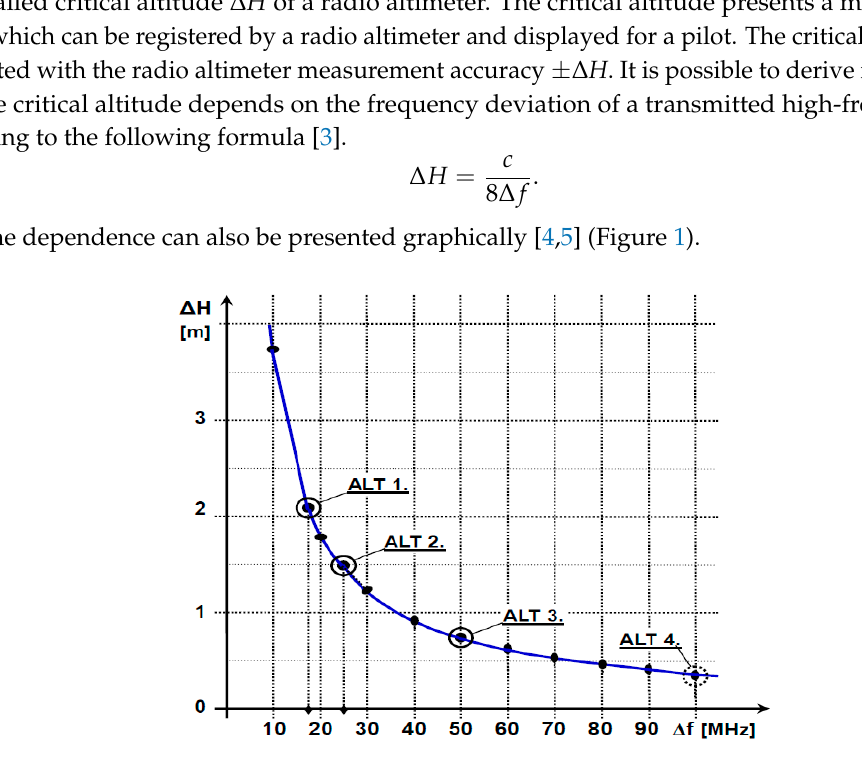
Figure 1. Dependence of the critical altitude Δ H on the frequency deviation Δ f .